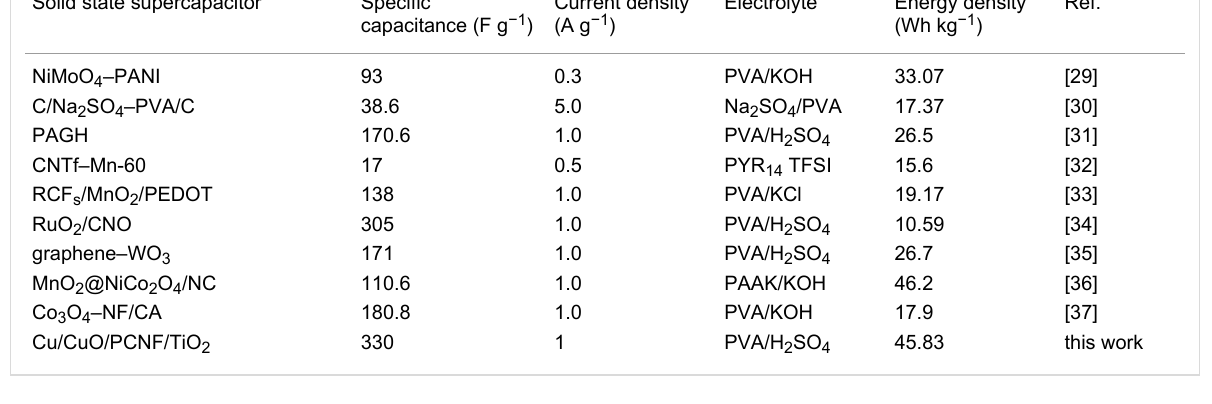
Table 1: Comparison of supercapacitive performance of fabricated SSHSCs with previous reports. Solid state supercapacitor